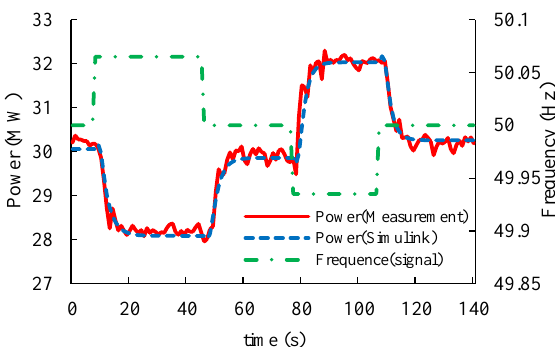
Figure 12. Comparison of active power change between hydropower plants (HPP) and the simulation model when the step signal is ±0.065 Hz.